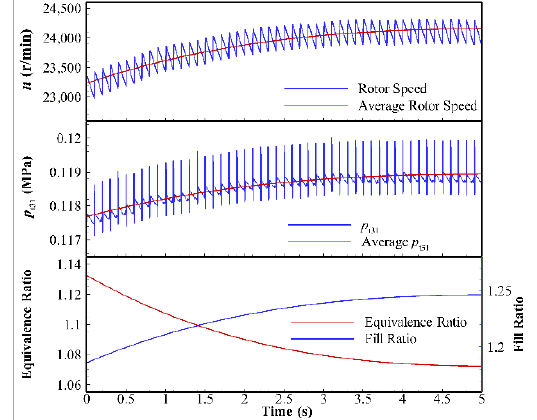
Figure 7. Dynamic response of PDTE with fuel changes.